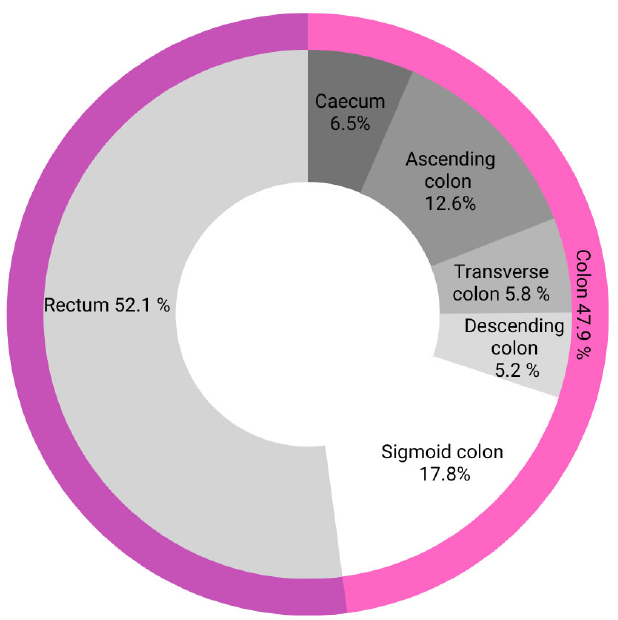
Figure 7. Localization of colorectal cancer with specific anatomical